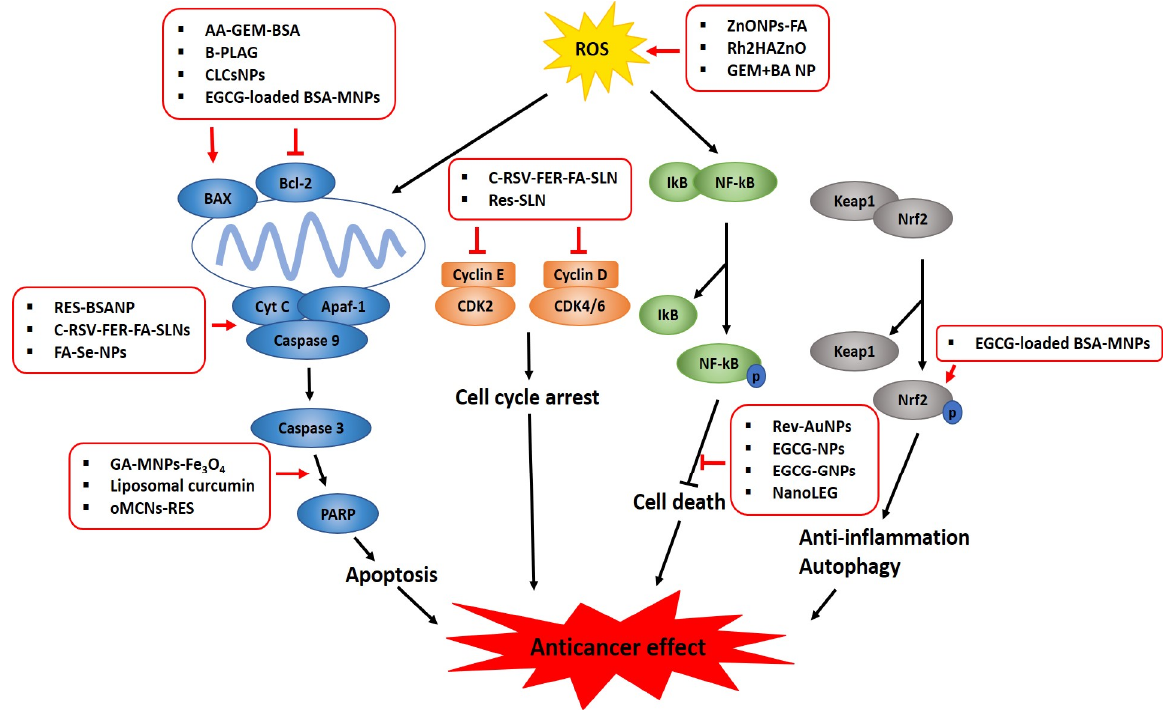
Figure 3. Graphical abstract on the molecular mechanism of nano-phytochemicals in cancers.